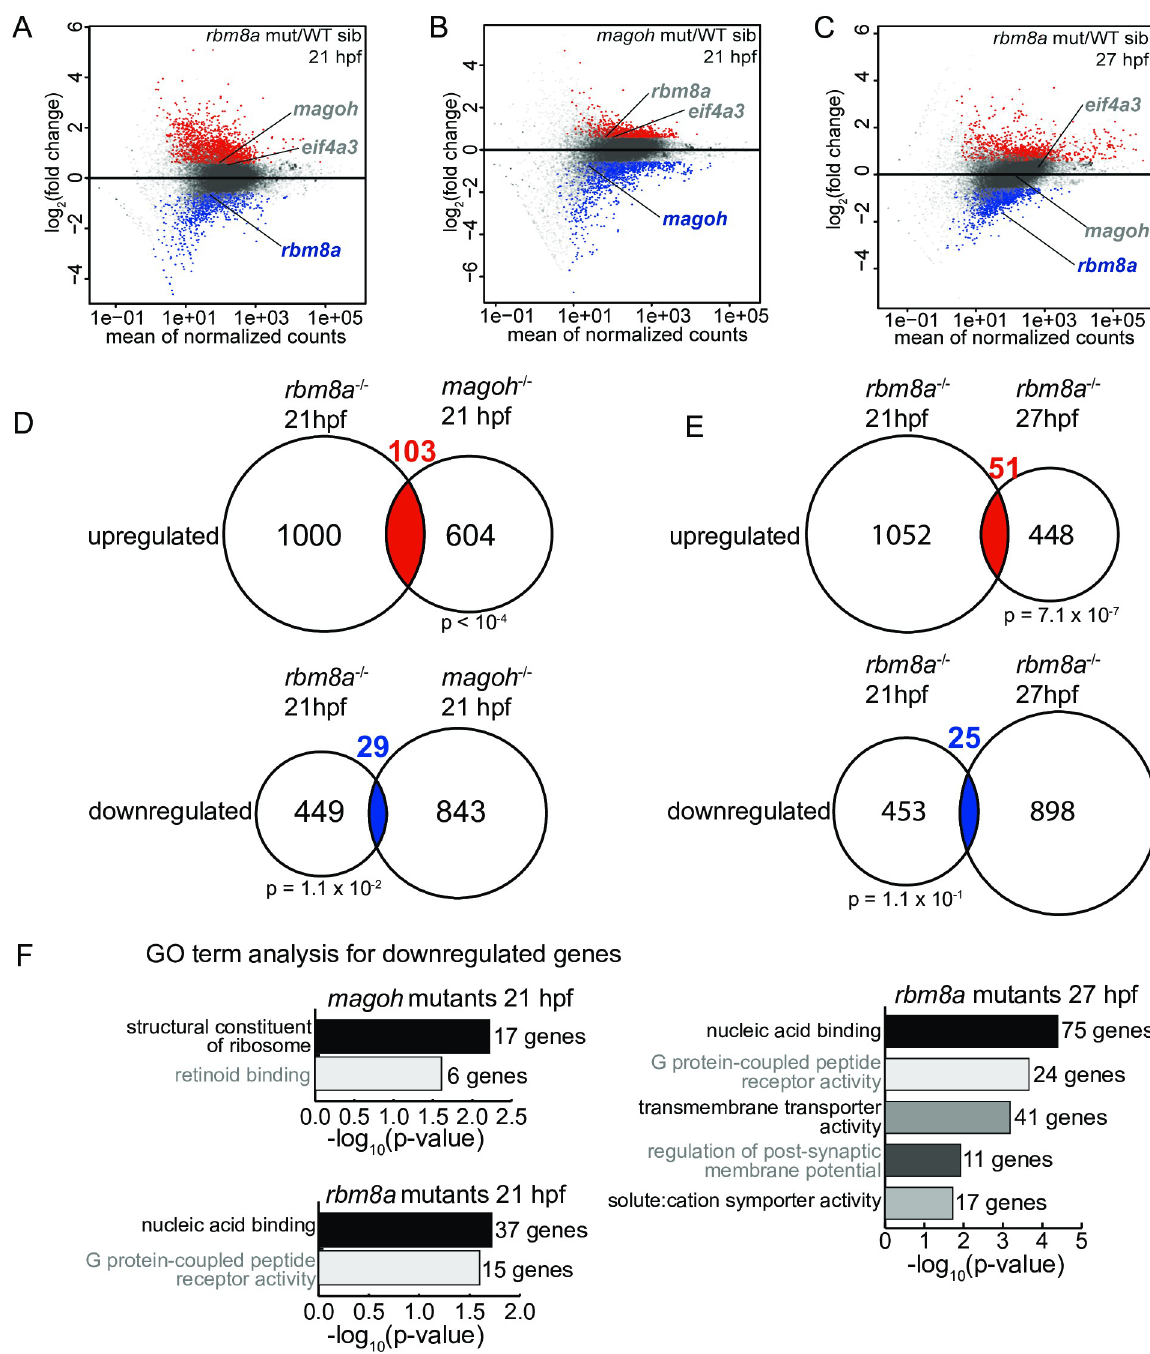
Fig 4. Gene expression changes in rbm8a and magoh mutant embryos. A-C. MA plots (M: log ratio; A: mean average) showing genes that are upregulated (fold change > 1.5 and FDR < 0.05) (red), downregulated (fold change < 1.5 and FDR < 0.05) (blue), or unchanged (gray) in rbm8a mutant embryos compared to WT siblings at 21 hpf (A), magoh mutant embryos compared to WT siblings at 21 hpf (B), and rbm8a mutant embryos compared to WT siblings at 27 hpf (C). rbm8a , magoh , and eif4a3 are labeled in each plot with label colors signifying no change (gray) or downregulation (blue). D. Venn diagrams showing the overlap between genes that are upregulated (top) and downregulated (bottom) in rbm8a mutant embryos at 21 hpf (left) and magoh mutant embryos at 21 hpf (right). Hypergeometric test p-values are below each comparison. E. Venn diagrams as in (D) comparing upregulated and downregulated genes in rbm8a at 21 (left) and 27 hpf (right). F. PANTHER14.0 [86] gene ontology (GO) term overrepresentation analysis of genes downregulated in rbm8a and magoh mutant embryos at indicated times. All significant terms (Benjamini-Hochberg corrected p-value < 0.05) are shown for each set. The number of genes in each term is indicated at the right of each bar. https://doi.org/10.1371/journal.pgen.1008830.g004 PLOS Genetics | https://doi.org/10.1371/journal.pgen.1008830 June 5,